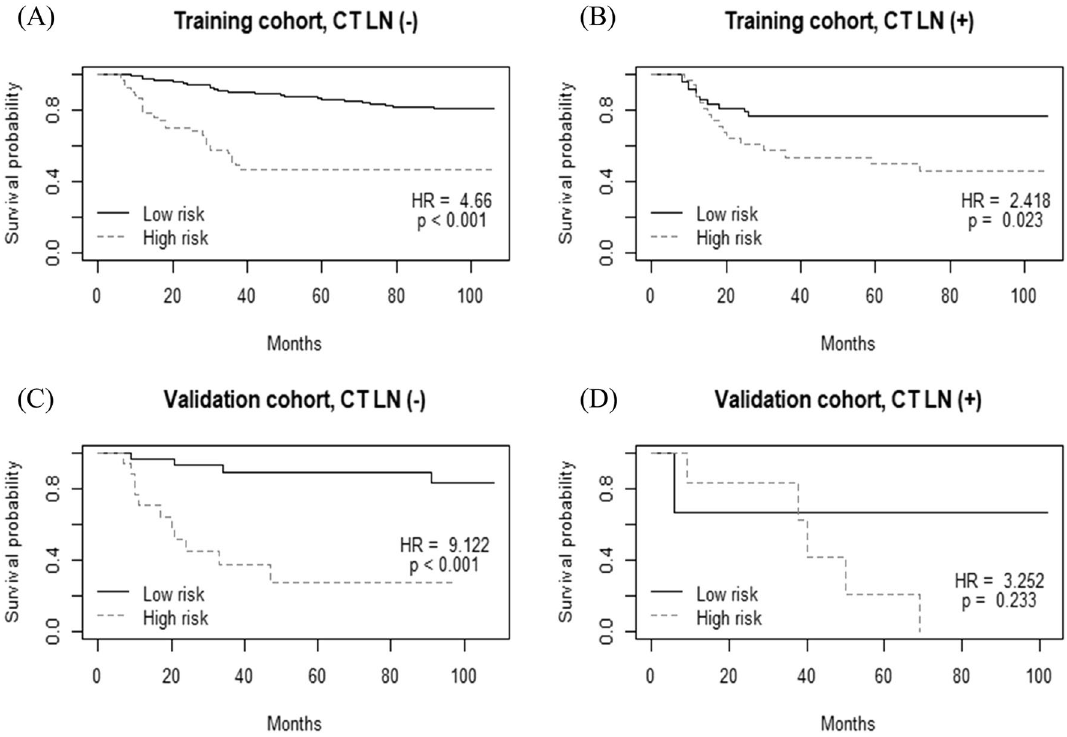
Figure 5. Kaplan–Meier survival analysis of recurrence-free survival according to the radiomics score classifier in subgroups of the training and validation cohorts. ( A ) Training cohort, lymph node (LN) stage 0 or 1 on CT (n = 269). ( B ) Training cohort, LN stage 2 or over on CT (n = 80). ( C ) Validation cohort, LN stage 0 or 1 on CT (n = 52). ( D ) Validation cohort, LN stage 2 or over on CT (n = 9). R software (version 3.3.2, https ://www.r-proje ct.org) was used to